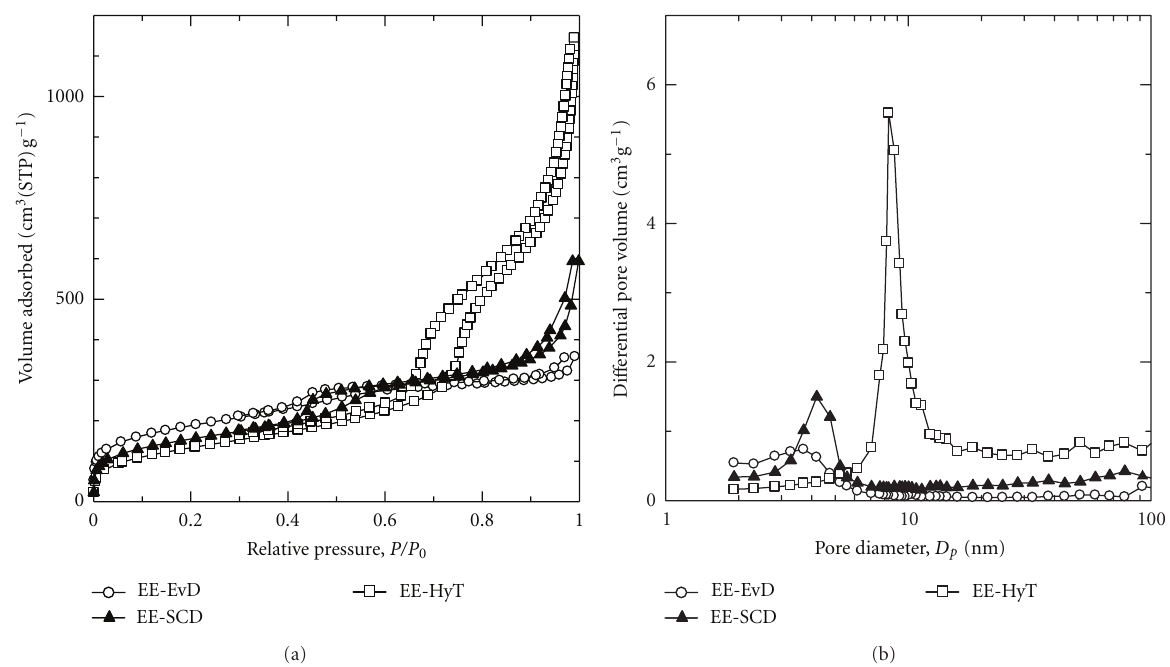
Figure 7: Adsorption-desorption isotherms (a) and di ff erential pore size distributions (b) of the EE-EvD, the EE-SCD and the EE-HyT samples.